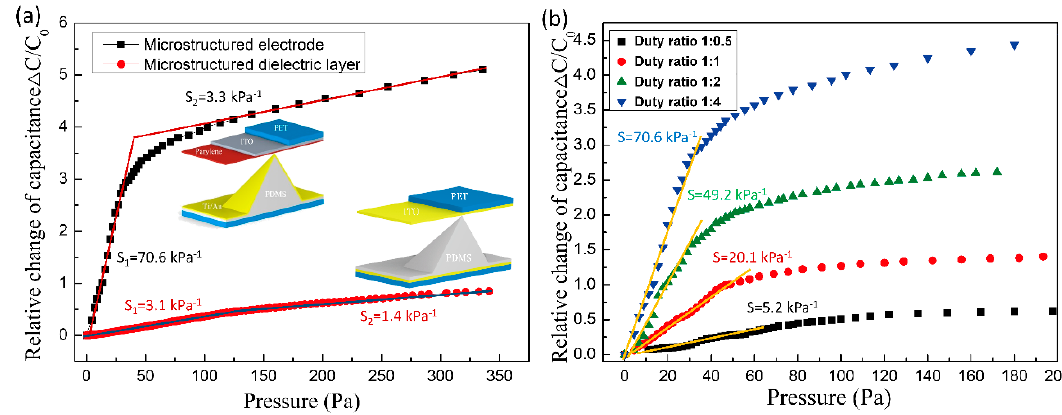
Figure 5. Performance of the flexible pressure sensor. ( a ) pressure–response curves for a CME and CMD with the same pyramid dimensions, ( b ) effect of pyramid duty ratio on the sensitivity of CME.